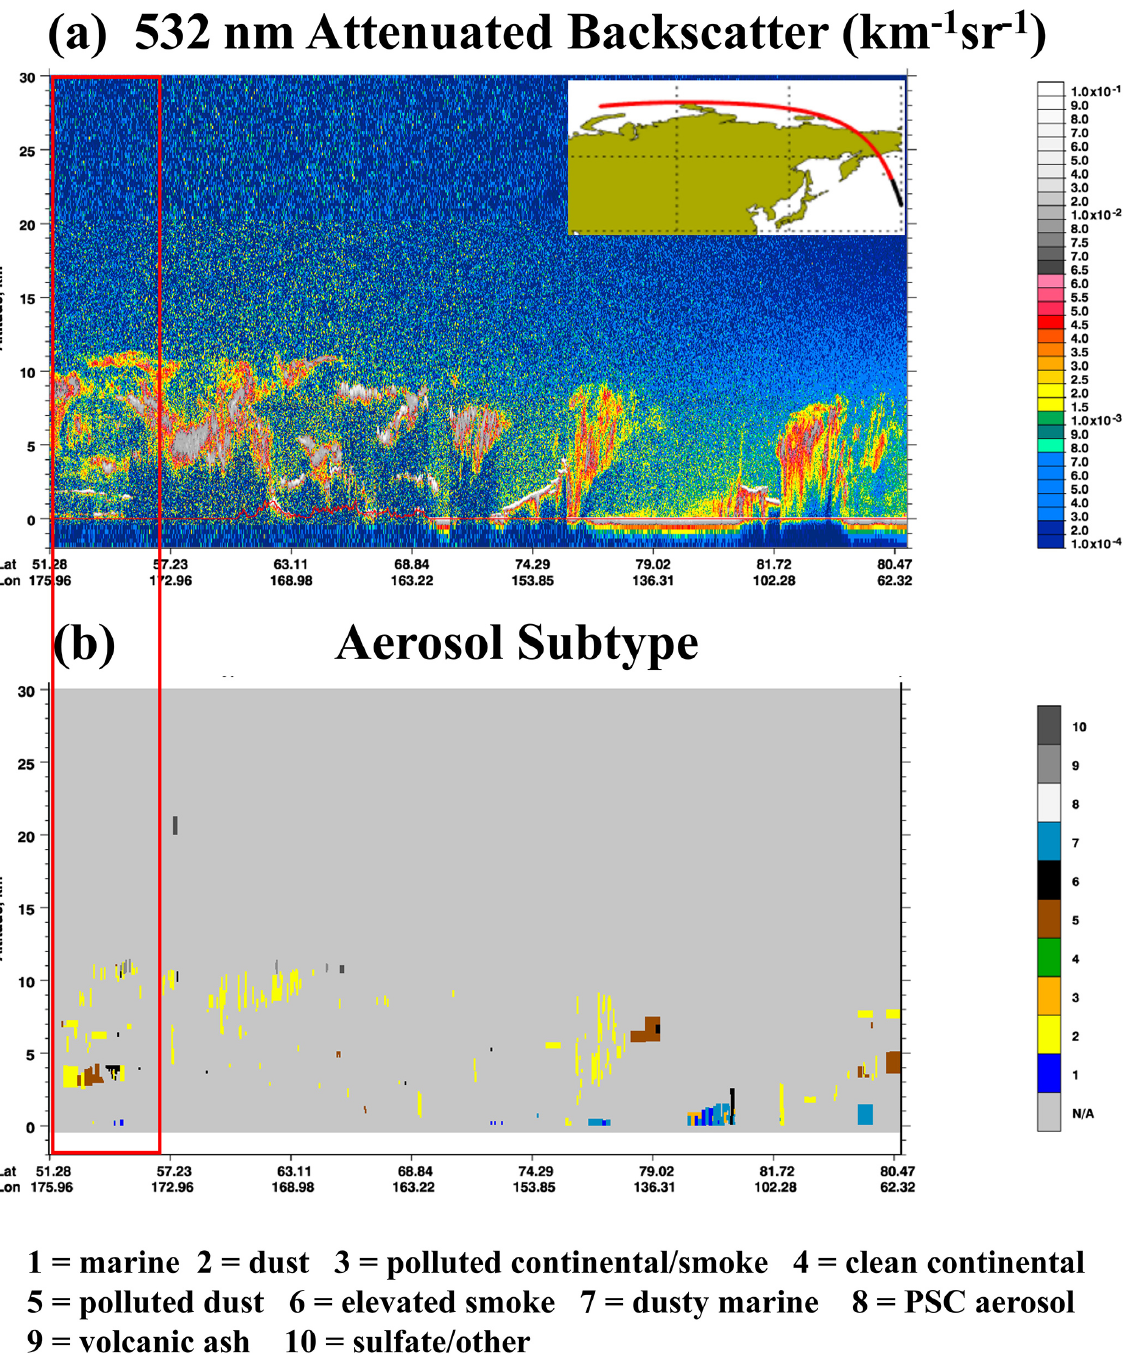
Figure 9. CALIPSO profiles of (a) aerosol backscattering coefficients and (b) identified aerosol types on 12 March 2013. The red rectangles denote the regions as indicated by the CALIPSO tracks in Fig.